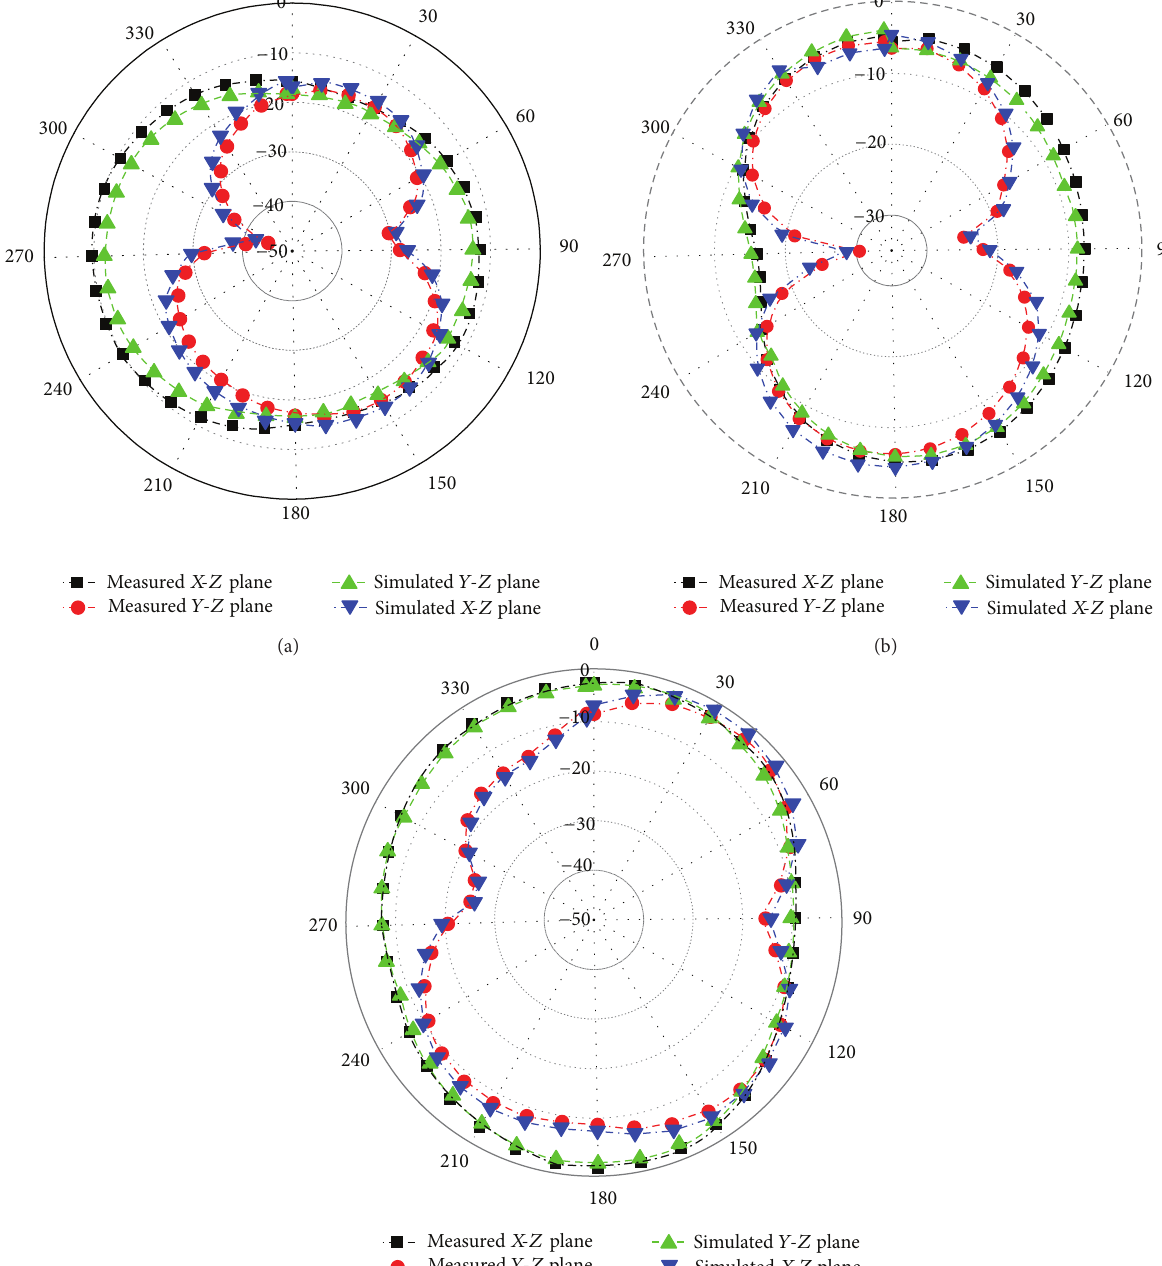
applications. In the design, by adding an extra slot in the Swastika shape patch and a wide square slot in the ground plane with four extra slits just under the Swastika patch, three resonant modes with good impedance performance are achieved. The measured − 10 dB impedance bandwidth of the proposed antenna covers 2.28– 3.23 GHz, 3.28–3.94 GHz, and 4.76–6.55 GHz, which meets